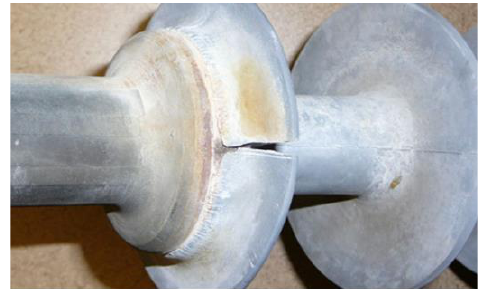
Figure 2. Deteriorated insulators that can be found by visual inspection [11]. (2) Hydrophobicity classification (HC) test.